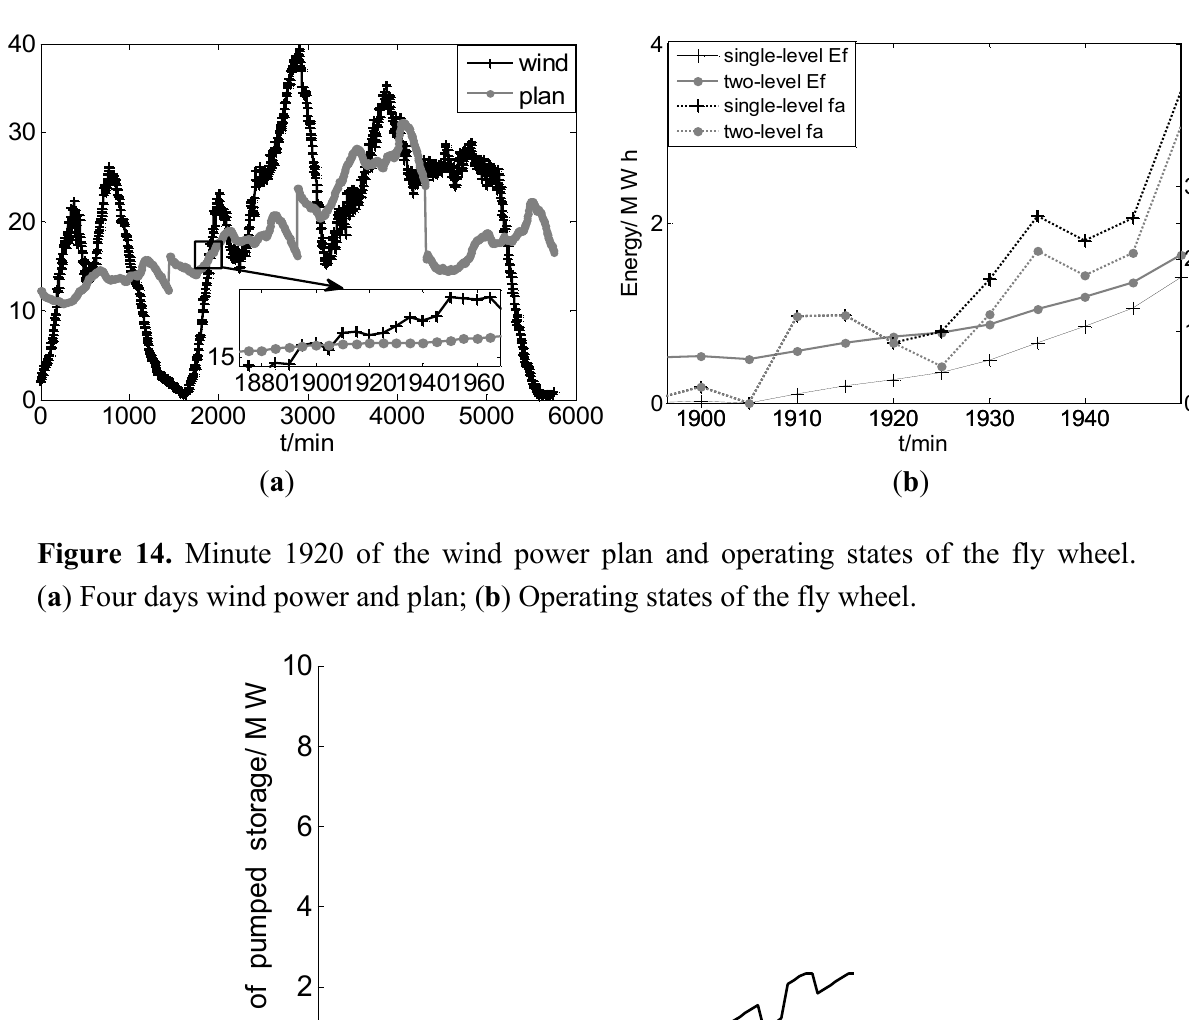
p of the pumped t